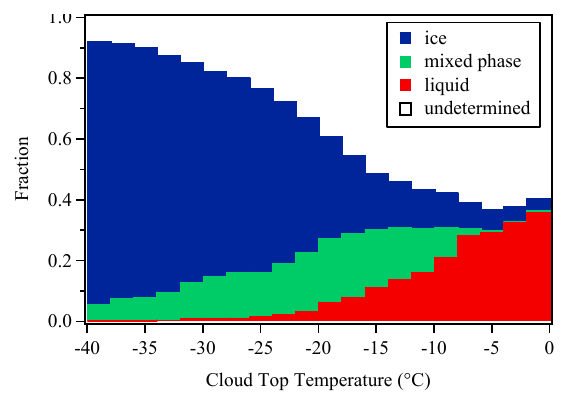
Fig.14. MODIS-indicatedhydrometeorphaseofcloudsforthegeographicregionandtimeperiodofAMAZE- Fig. 14. MODIS-indicated hydrometeor phase of clouds for the ge- 08. Plotted against cloud-top temperature is the fraction of ice (blue), mixed phase (green), and liquid clouds ographic region and time period of AMAZE-08. Plotted against (red). Thefractionismadewholebyawhiteregionrepresentingthefractionoftimeduringwhichhydrometeor cloud-top temperature is the fraction of ice (blue), mixed phase phasecouldnotbedetermined. (green), and liquid clouds (red). The fraction is made whole by a white region representing the fraction of time during which hy- drometeor phase could not be